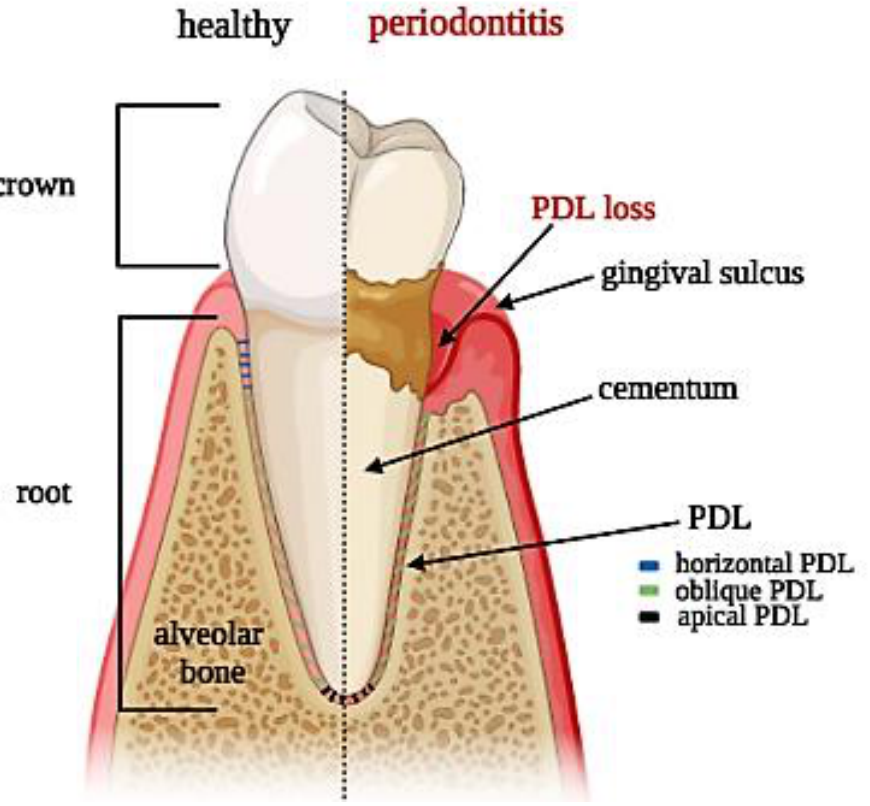
Figure 1. Tooth section showing periodontal ligament anatomy: superficial and deep periodontium along with the typical distribution of PDL fibers in both physiological and pathological conditions.